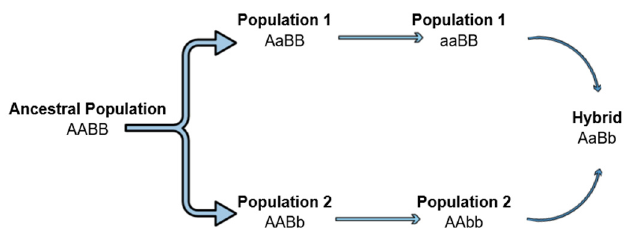
Figure 2. Dobzhansky–Muller incompatibilities can lead to the hybrid breakdown. An ancestral population separated into two lineages. Mutations arise in different loci of the two lineages. Mutations become fixed, and when the two lineages hybridize, a hybrid breakdown is observed as the new alleles can be incompatible.